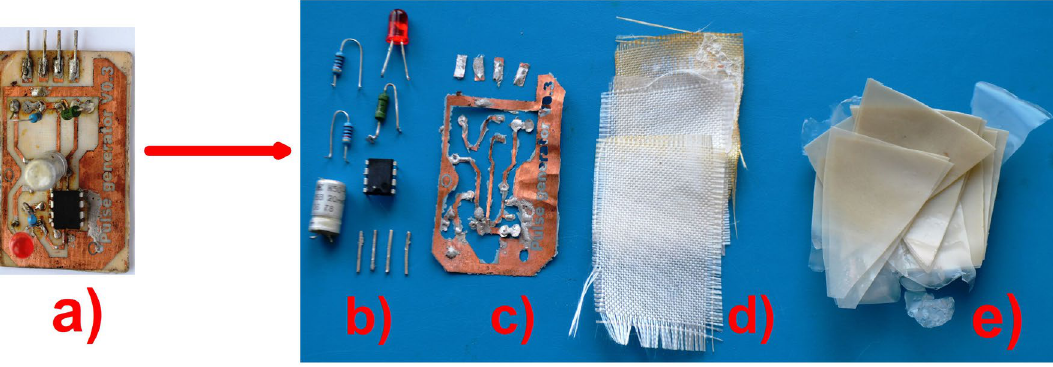
Figure 3. PCB recycling: ( a ) lab-made PLA-PCB; ( b ) electronic components; ( c ) copper tracks; ( d ) fiberglass; ( e ) polylactic acid, after the recycling